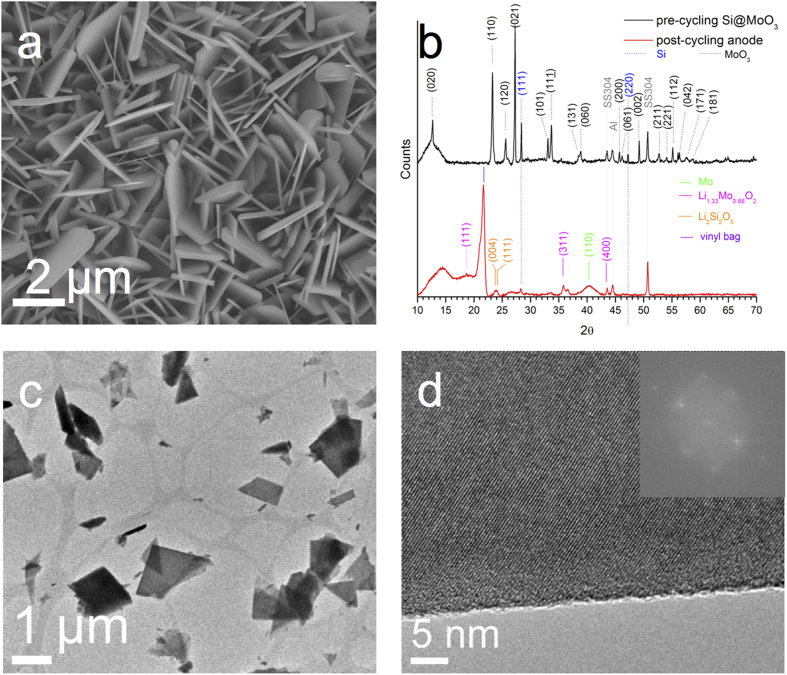
As-deposited MoO3 nanoplatelet arrays a) SEM (top view), b) XRD of Silicon loaded anode MoO3 [JCPDS 00–035–0609], Si [JCPDS 00–027–1402] before and after cycling Li1.333Mo0.666O2 [JCPDS 01–073–2300], Li2Si2O5 [JCPDS 00–015–0637] c) brightfield TEM of MoO3 platelets, d) HR-TEM of MoO3 platelet, inset FFT.